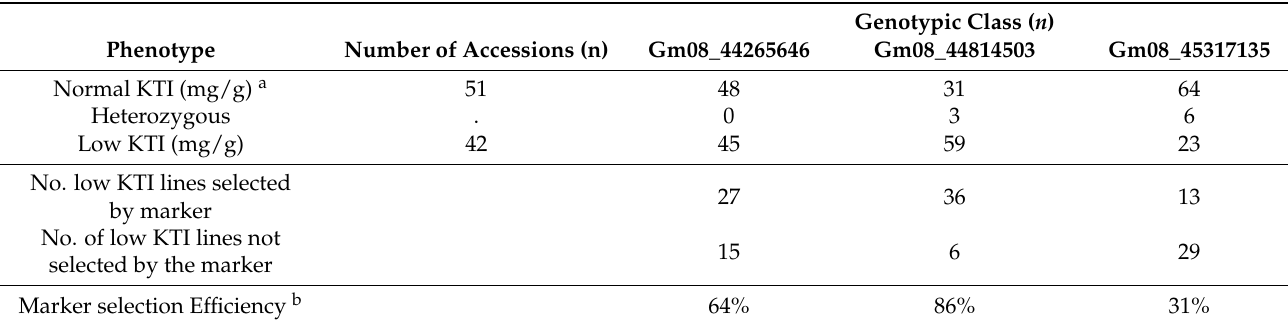
Table 8. Selection efficiency of the SNP assays in 93 Plant Introductions (PIs) collected by the National Genetic Resources Program to form a MGs IV and V core